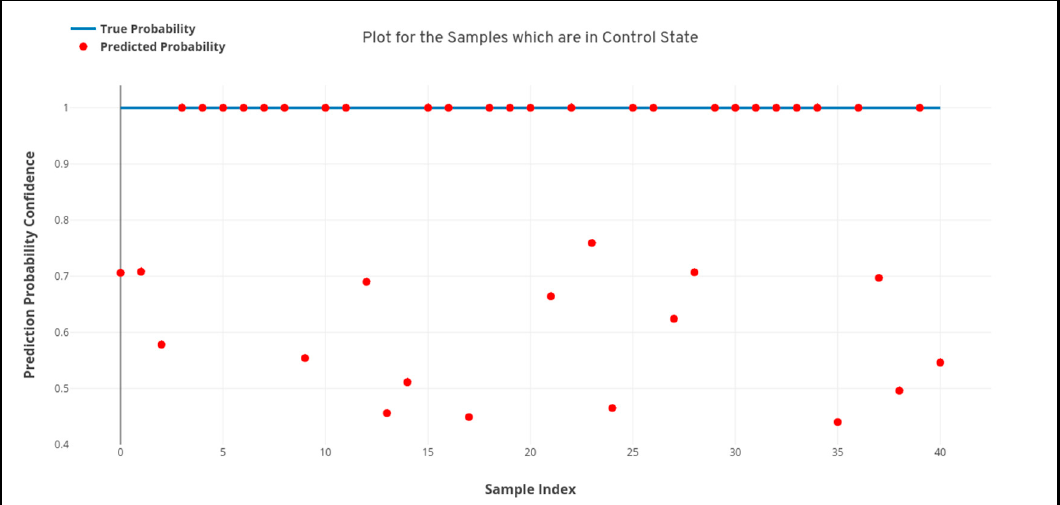
Figure 8. Quantile-quantile plot between the true probability and the prediction probability of the samples belonging to the control class. Probabilistic confidence is 0.82.